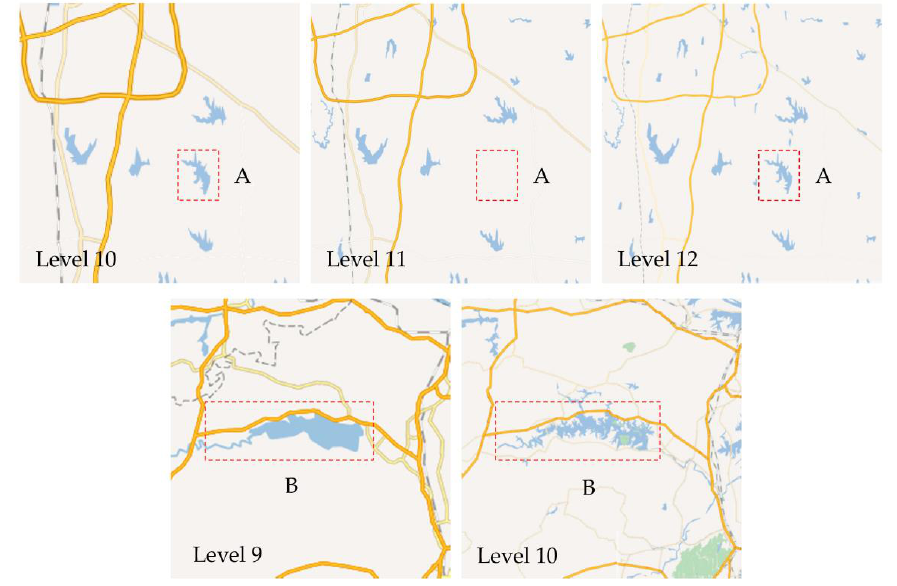
Figure 1. Inconsistencies between lakes at different scales.